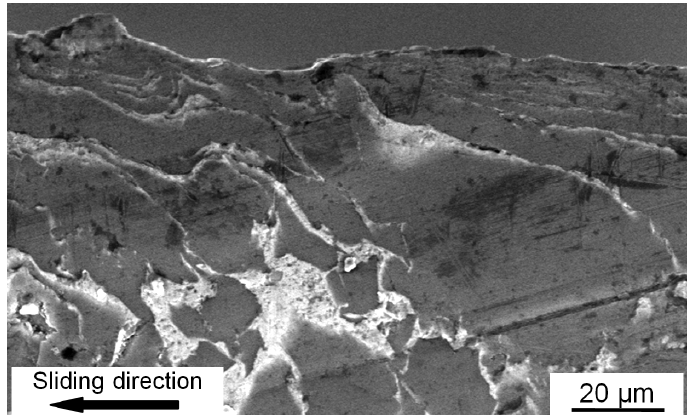
Figure 7. SEM (SE) images of the subsurface layer structure of the ECAP-ed Al-30Sn sample after dry friction against steel; P = 1 MPa; V sl = 0.07 m/s; L = 1000